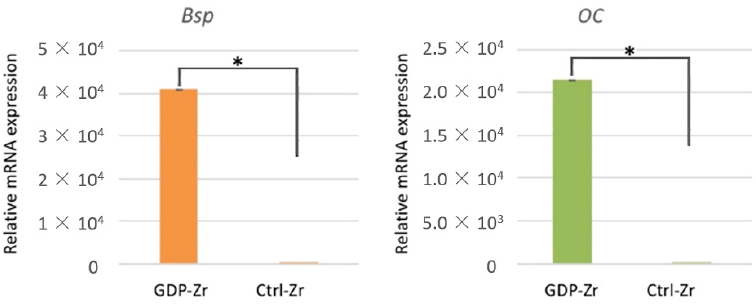
Figure 5. Osteogenic markers in MG-63 cells on day 5. The Bsp and OC relative gene expressions in the MG-63 cells cultivated on plasma-treated Zr discs were higher than the ones cultivated on the control Zr discs. * p < 0.05.